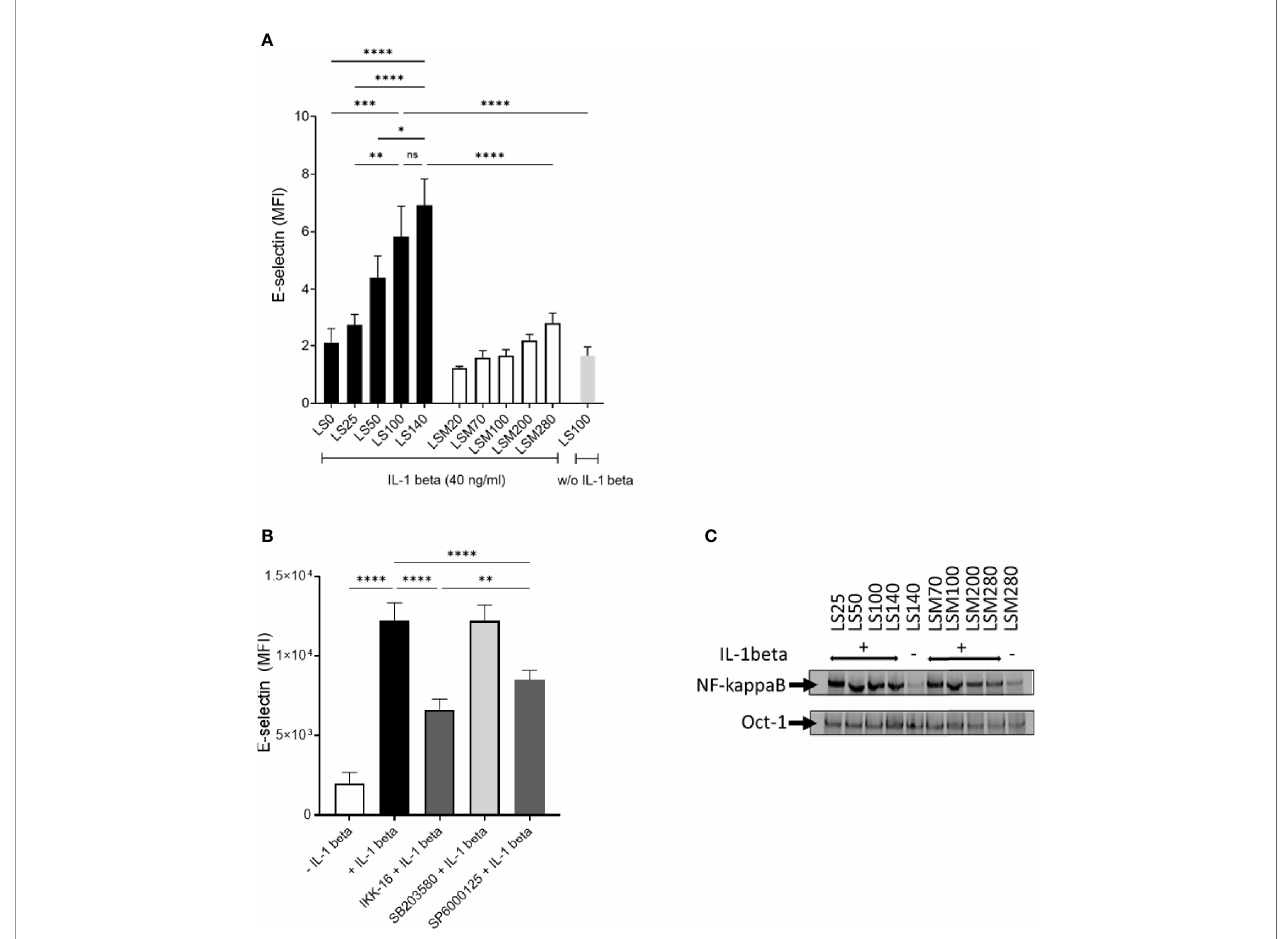
FIGURE 2 | Lowering NaCl concentration in cell culture medium inhibits cytokine-induced E-selectin expression on endothelial cells in a NF-kappaB-independent manner. (A) Murine mesenteric lymph node – derived endothelioma cells ( mlEnds ) were cultured in solutions under respective conditions for 24 h before E-selectin was induced by IL-1 beta (40 ng/ml) for 4 h. E-selectin expression on mlEND cell surface was analyzed by fl ow cytometry and expressed as mean fl uorescence intensities (MFI). * p < 0.05, ** p < 0.01,*** p < 0.001, **** p < 0.0001, ns = non-signi fi cant. p -values were calculated by one-way ANOVA followed by Bonferroni ’ s multiple comparisons test. All data were expressed as ± SEM from three independent experiments with technical duplicates. (B) mlENDs were pre-treated with an NF-kappaB inhibitor (IKK16;500 nM), a p38 inhibitor (SB203085;10 µM), and a JNK inhibitor (SP6000125; 10 µM) for 1 h before E-selectin expression was induced by IL-1 beta. MFIs of E-selectin are shown. **** p < 0.0001. p -values were calculated by one-way ANOVA followed by Bonferroni ’ s multiple comparisons test. All data were expressed as ± SEM from three independent experiments with technical duplicates. (C) Electrophoretic mobility shift assay (EMSA) to analyze NF-kappaB nuclear DNA-binding activity under NaCl restriction. mlENDs were cultured in respective media (LS25, LS50, LS100, LS140, LSM20, LSM70, LSM200, and LSM280) and incubated for 1 h with 40 ng/ml IL-1 beta. Nuclear extracts were applied to NF-kappaB and Oct-1 EMSA. Oct-1 was used as loading control. One representative independent experiment out of four experiments is